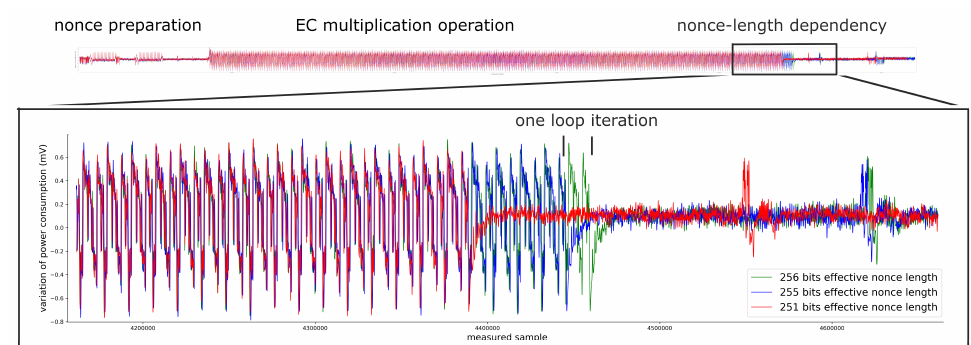
Figure 2: The visible leakage of nonce’s bit-length on a power consumption trace of the Athena IDProtect smartcard as captured by an ordinary oscilloscope at 40MHz sampling frequency for three signatures (aligned) with nonces having 0, 1 and 5 leading zero bits. The zoomed region of the whole ECDSA operation displays the difference at the end of the multiplication operation. The pattern corresponding to a single iteration of the scalar multiplication algorithm is clearly discernible, allowing an attacker with physical access to a card to establish the bit-length of the nonces precisely and with no error. Note that captured powertrace is presented only to highlight the root cause of vulnerability – the oscilloscope is not required for the successful